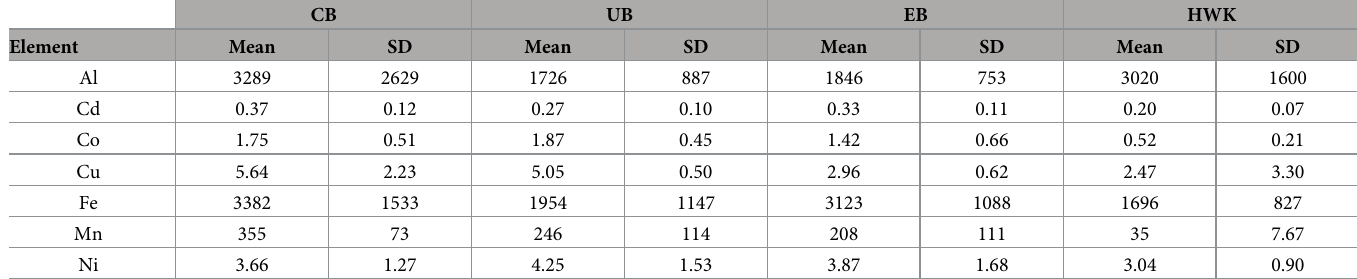
Table 1. Table of mean seagrass metal concentrations. Mean concentration (mg/kg dw) and standard deviation (SD) of metal elements at each coastal site (CB, UB and EB) pre-wet season, and data from a foraging ground at the offshore site HWK, provided by Thomas et al